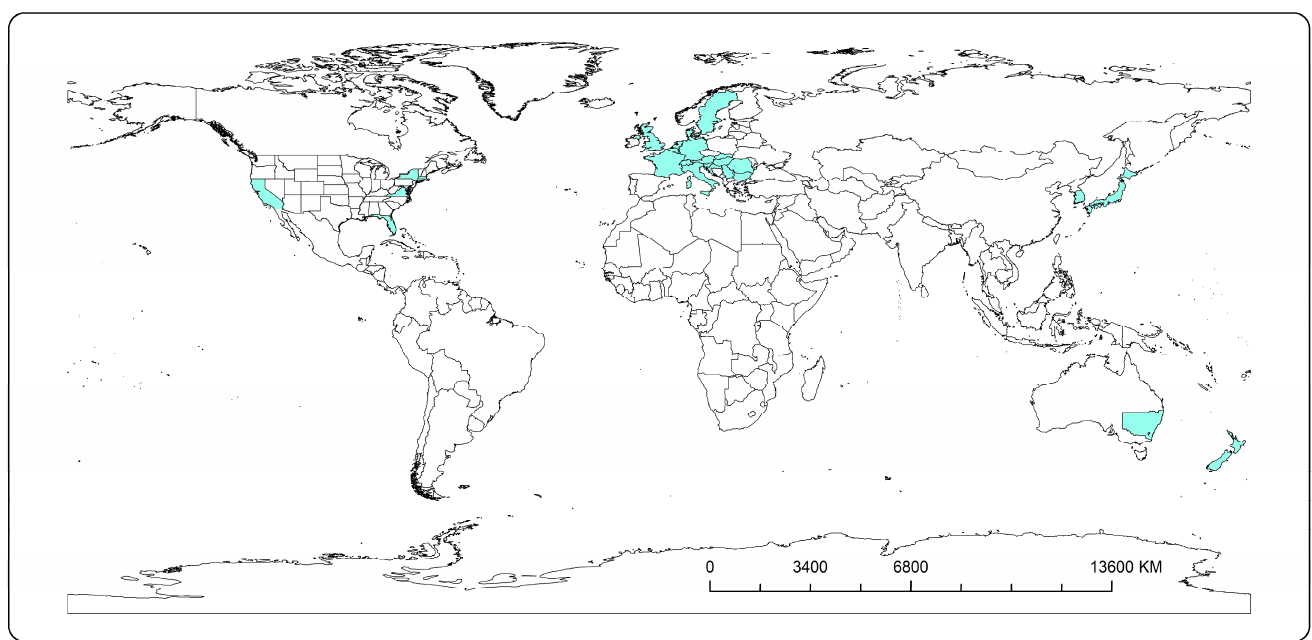
Figure 4. Updated distribution map of P. hydrangeae worldwide (green color); due to the size, the Canary Islands and Hong Kong are not visible here.